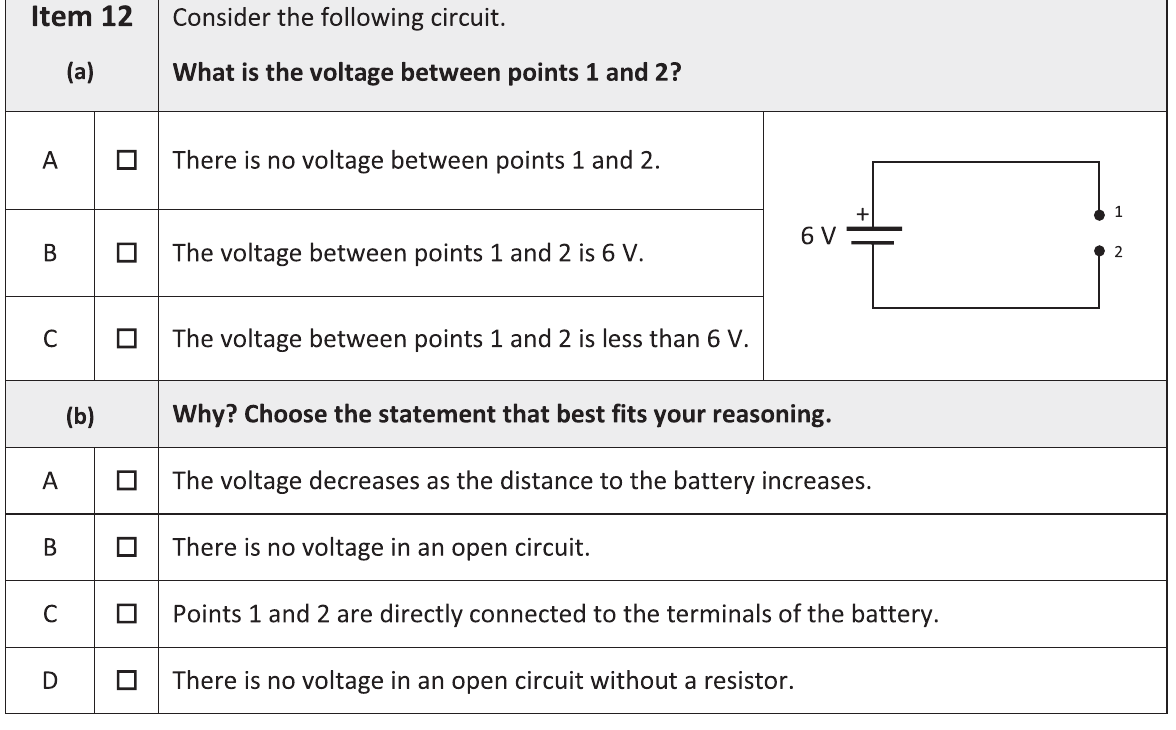
FIG. 1. Example of an item on electric